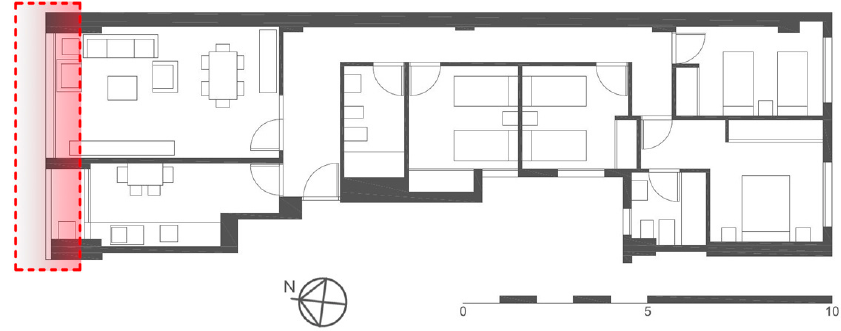
Figure 4. General floor view of type C flat.